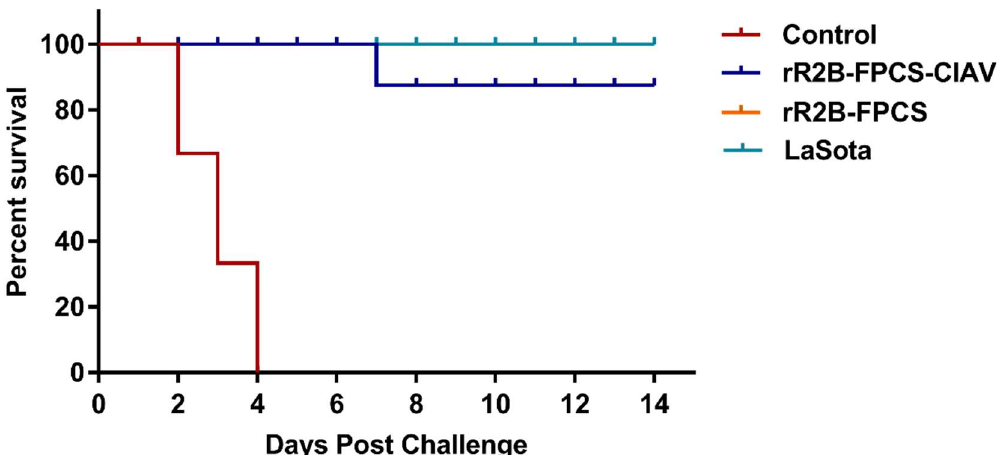
Figure 7. Survival curve for birds immunised with rR2B-FPCS-CIAV, rR2B-FPCS and LaSota. Birds were challenged with 10 5 ELD 50 / mL NDV virulent virus at 84 days of age and survivability was assessed up to 14 dpc. All birds in the control group died by 4 dpc and one bird belonging to rR2B-FPCS-CIAV and rR2B-FPCS died by 7 dpc. All birds belonging to LaSota vaccine survived till the experimental study period.